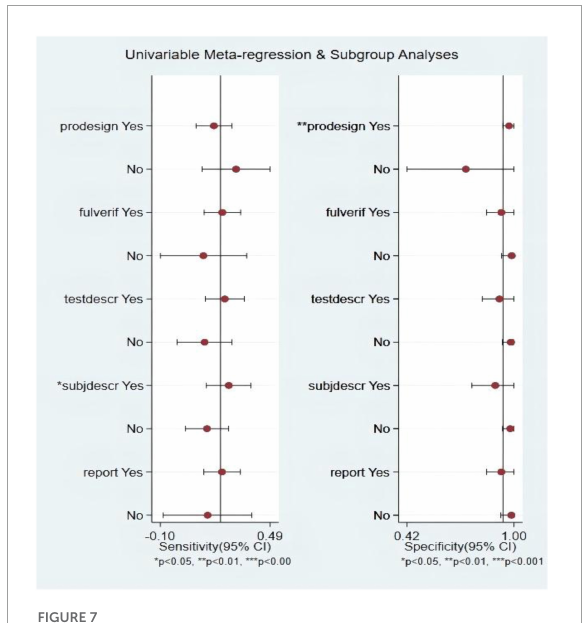
FIGURE7 Multiple univariate meta-regression and subgroup analysis. Prospective design: prodesign; fulverif: partial verification bias; subjdescr: adequate description of study participants; brdspect: broad spectrum of